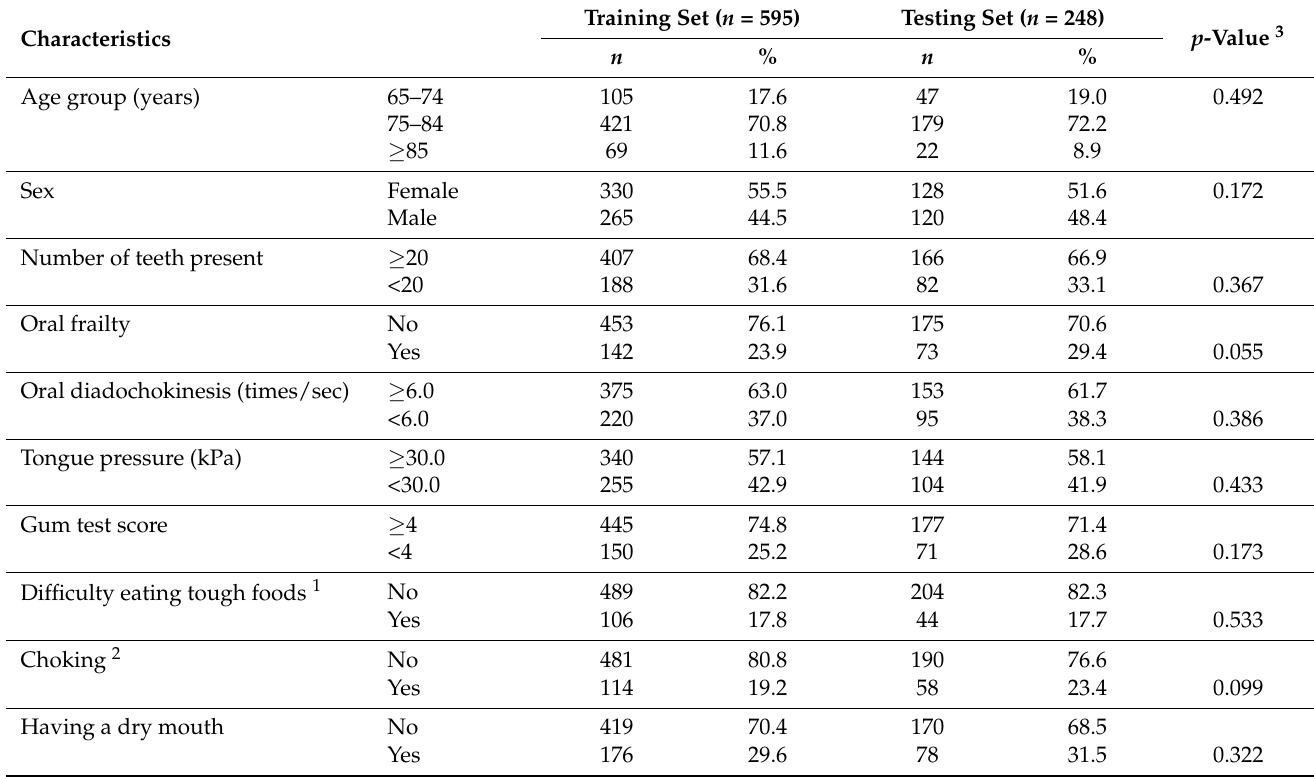
Table 1. Demographic and clinical characteristics of subjects in the training and testing